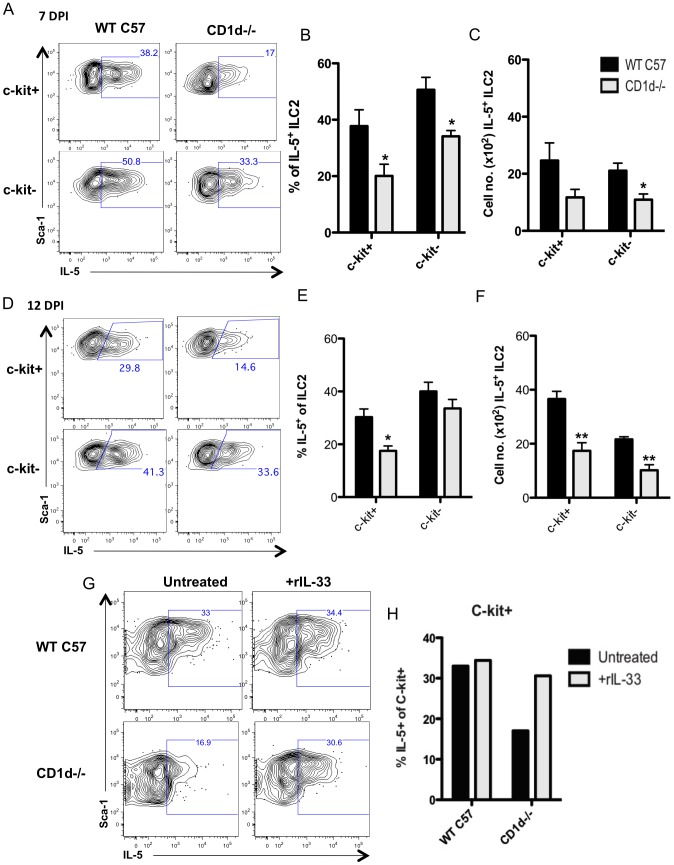
NKT cell deficient mice have fewer IL-5 producing ILC2.Lungs from infected CD1d−/− or C57BL/6 (WT C57) were harvested at 7 (A–C) and 12 d.p.i. (D–E). (A) IL-5 production was measured in each ILC2 subset via the ex vivo intracellular cytokine assay (B) Total frequency and (C) number of IL-5+ c-kit+ or c-kit− ILC2 at 7 d.p.i.. (D) ILC2 subsets from 12 d.p.i. lungs were examined as in (A). (E) Frequency and (F) total number of IL-5+ ILC2 subsets at 12 d.p.i.. (G) Whole lung cell suspensions from WT or CD1d−/− mice at 12 d.p.i. were treated with 20 ng/ml rIL-33 for 24 hours in culture and analyzed for intracellular IL-5 in ILC2. (H) Percentage of IL-5+ c-kit+ ILC2 after treatment with rIL-33. Data is representative of 2 (G–H) and 4 (A–F) independent experiments with 2–4 mice per group. Bars = +/− SEM. *p<.05, **p<.01.